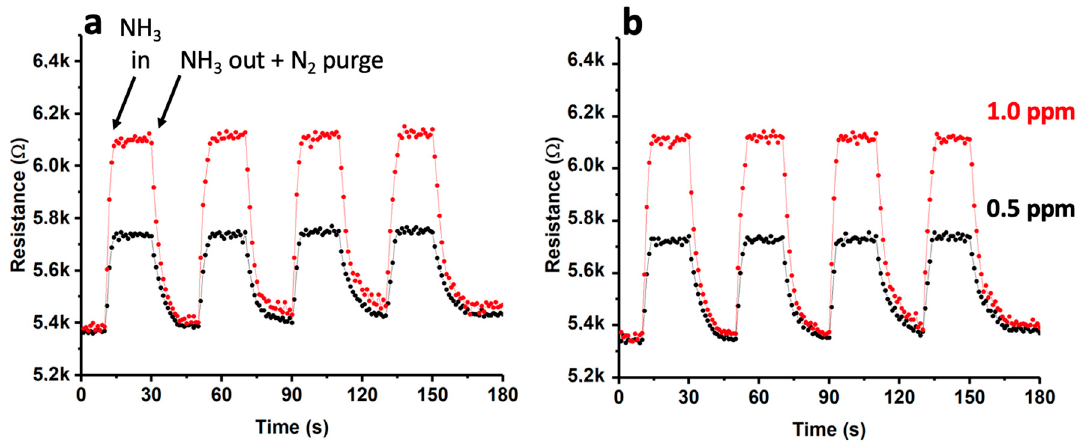
Figure 11. Dynamic response curves for the MoS 2 -Au(sputtering)-SWCNT composite gas sensor towards NH 3 (0.5 ppm and 1 ppm) at 25 °C ( a ) and 140 °C ( b ).